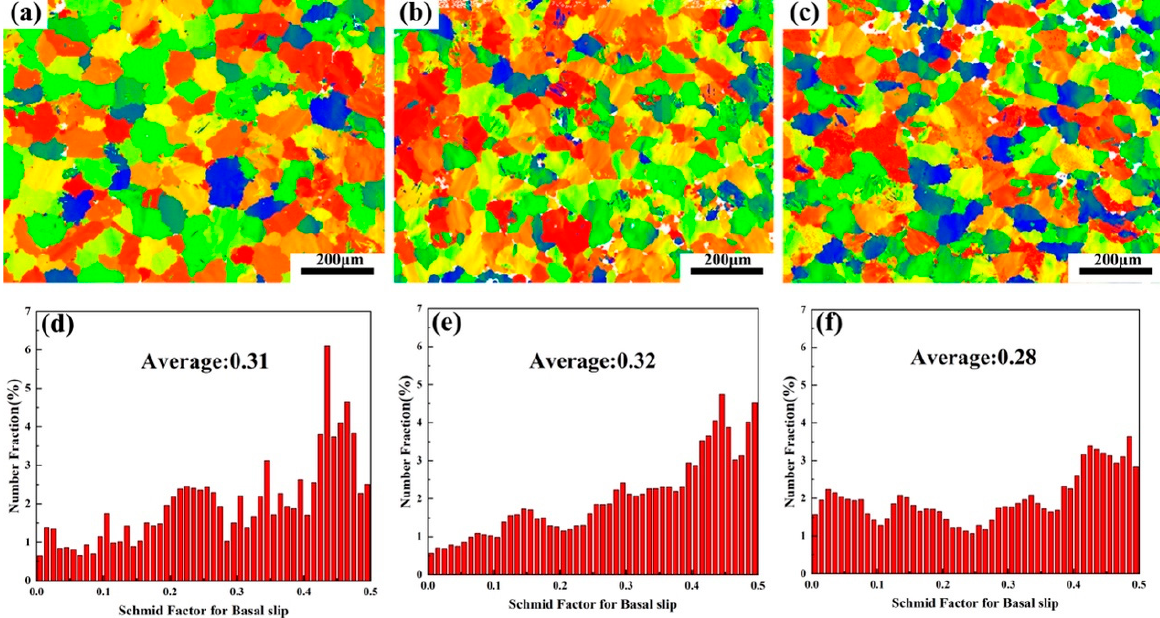
Figure 12. Basal slip Schmid factor (SF) distribution of three alloys: ( a , d ) Alloy A, ( b , e ) Alloy B, ( c , f ) Alloy C.